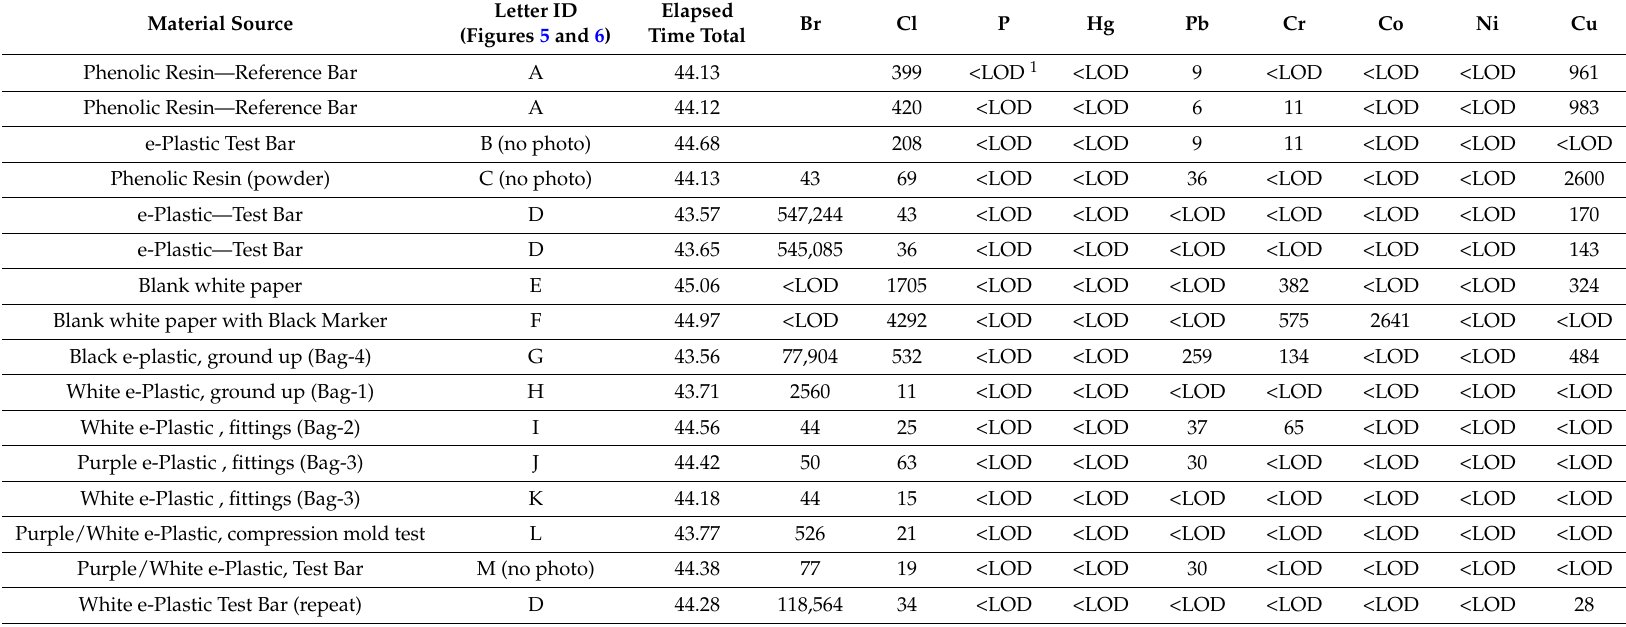
Table 1. Hand-held XRF data for analysis of selected elements in e-plastics.